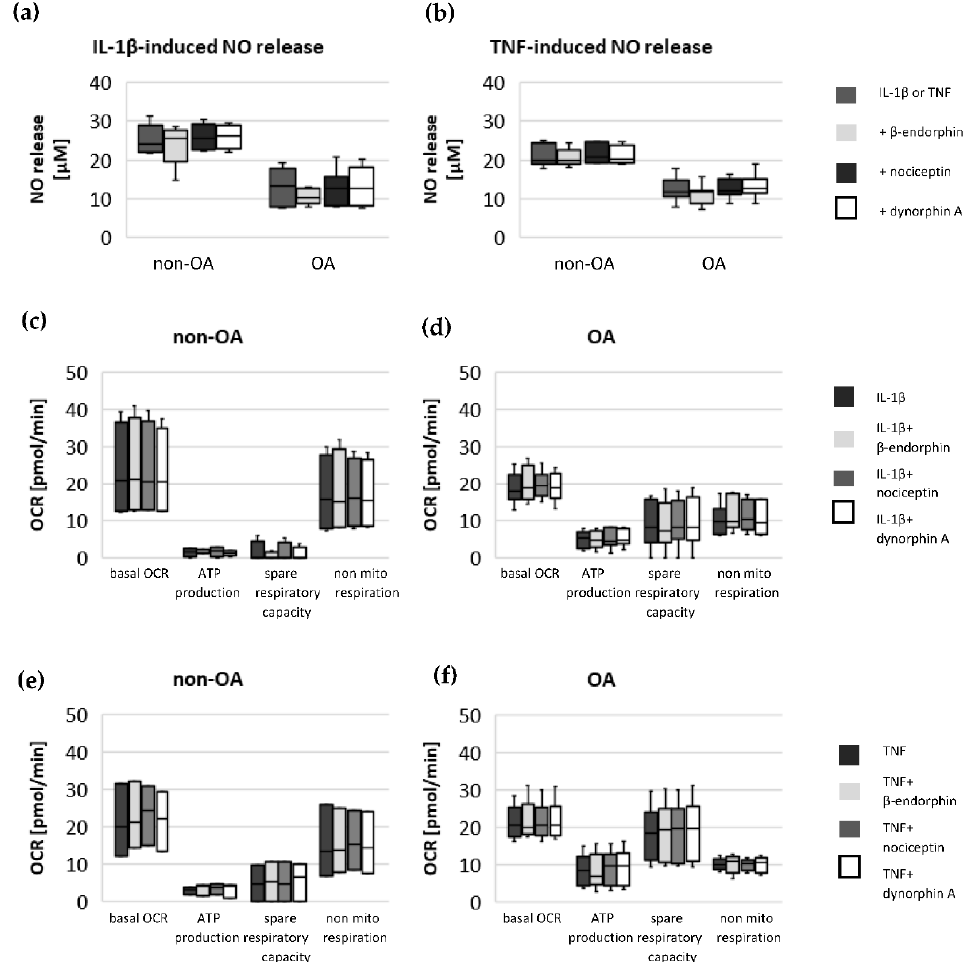
Figure 7. Impact of opioid neuropeptides on the ( a ) IL-1 β -induced and ( b ) TNF-induced release of